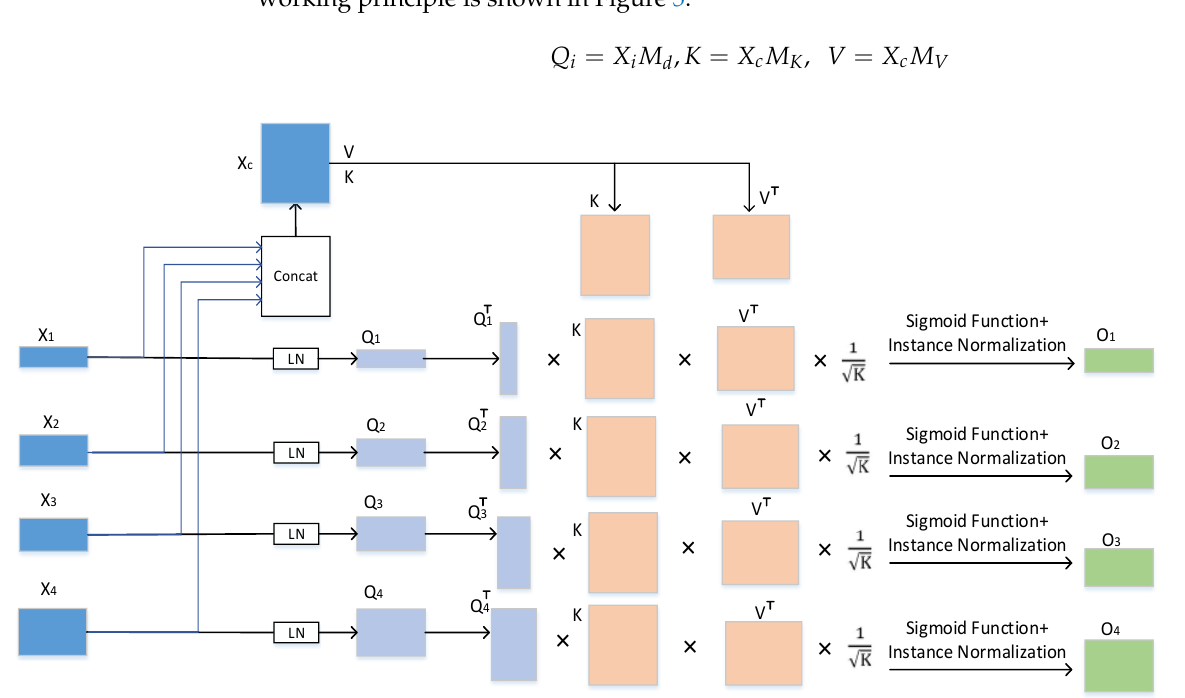
Figure 5. Operation schematic diagram of the transformer.